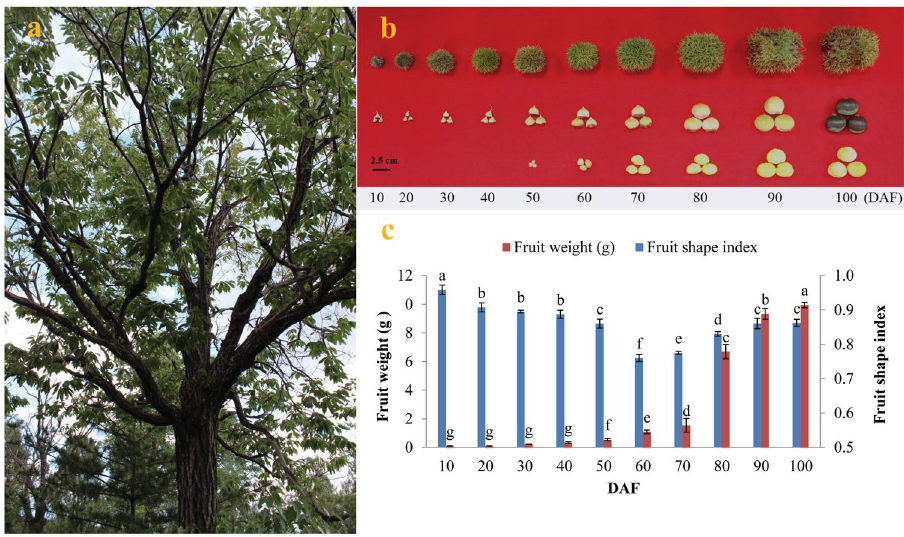
Figure 1. Features of Castanea mollissima fruits. ( a ) Castanea mollissima during fruiting. ( b ) Features of fruits at different developmental stages. ( c ) Fresh weight and fruit shape index (ratio of longitudinal and transverse diameters) of developing fruits. Error bars display SD, n =